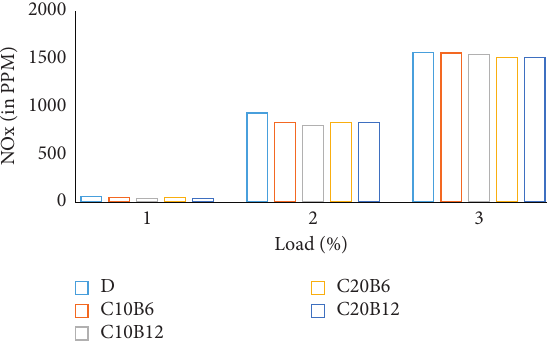
Figure 11: CO ₂ versus load for PPME samples